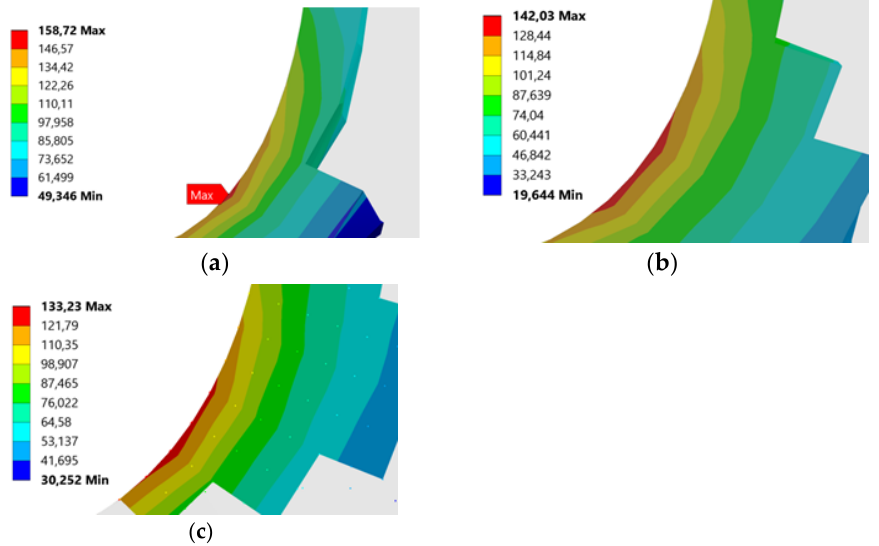
Figure 10. Root stress results for standard steel gears generated rack tip radius; ( a ) ρ 1 = 0.1 xm, ( b ) ρ 1 = 0.2 xm, ( c ) ρ 1 = 0.3 xm.